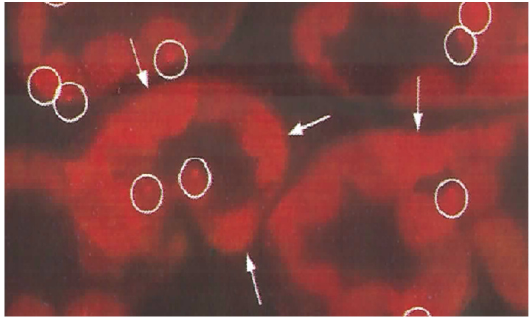
Figure 3. Microscopic analysis of ginsenoside Rb1 using the anti-ginsenoside Rb1 monoclonal antibody (author’s unpublished data). The circles and arrows indicate peroxisomes and chloroplasts, respectively.